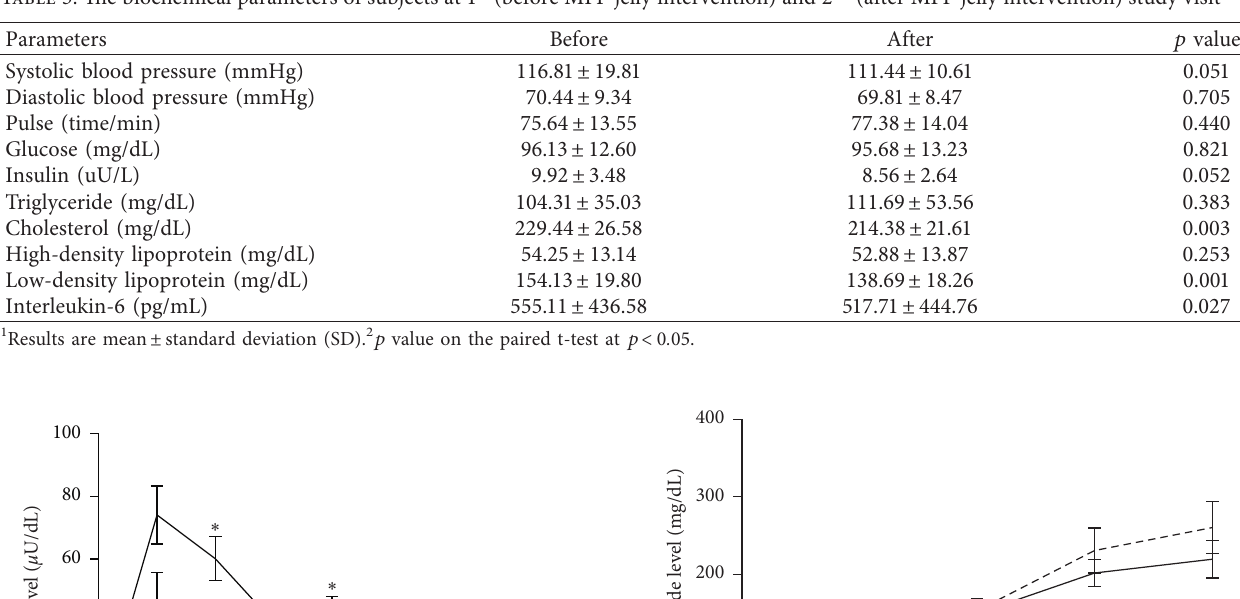
Table 5: The biochemical parameters of subjects at 1 st (before MFP jelly intervention) and 2 nd (after MFP jelly intervention) study visit 1,2 .